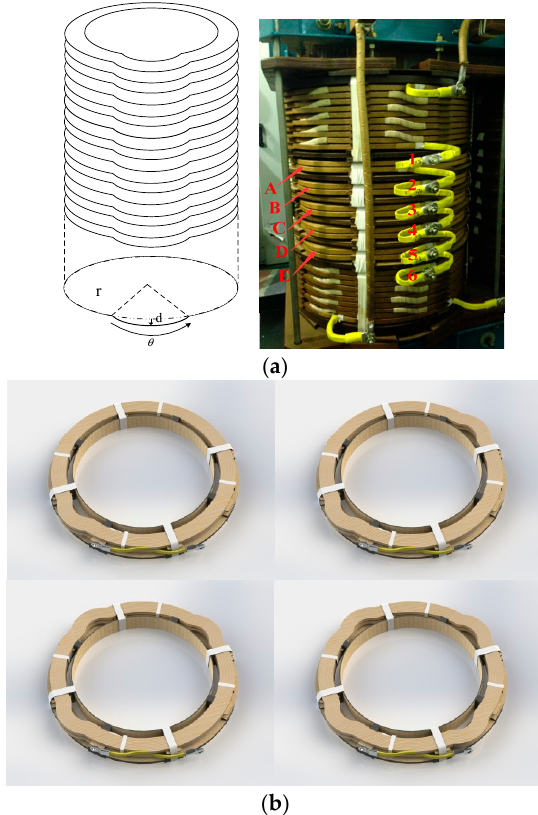
Figure 3. Diagrammatic sketch of winding radial deformation (RD): ( a ) diagram and image of RD; ( b ) 3D visualization of winding RD with faults manufactured at different directions.